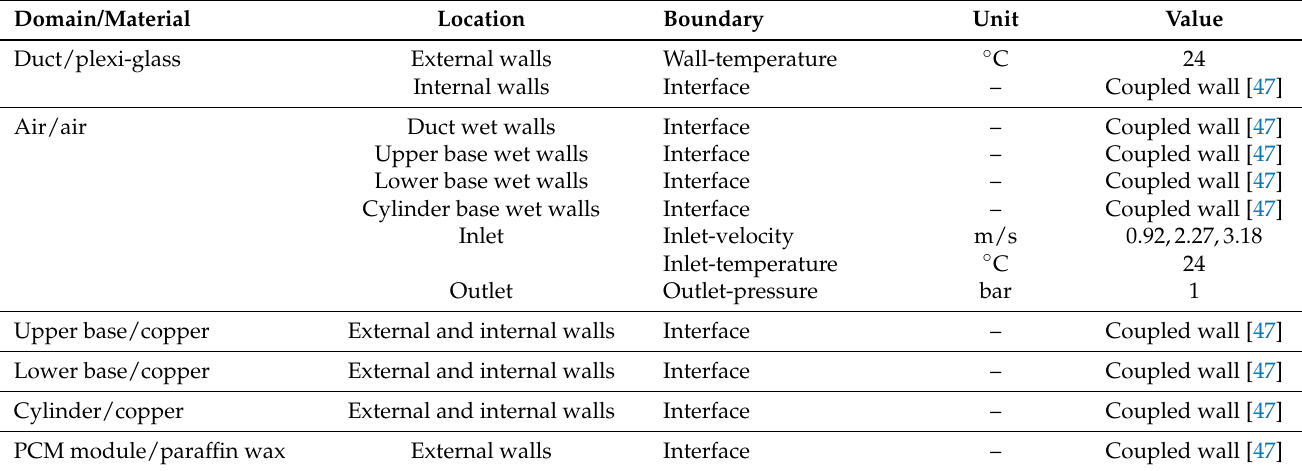
Table 5. Boundary conditions employed during